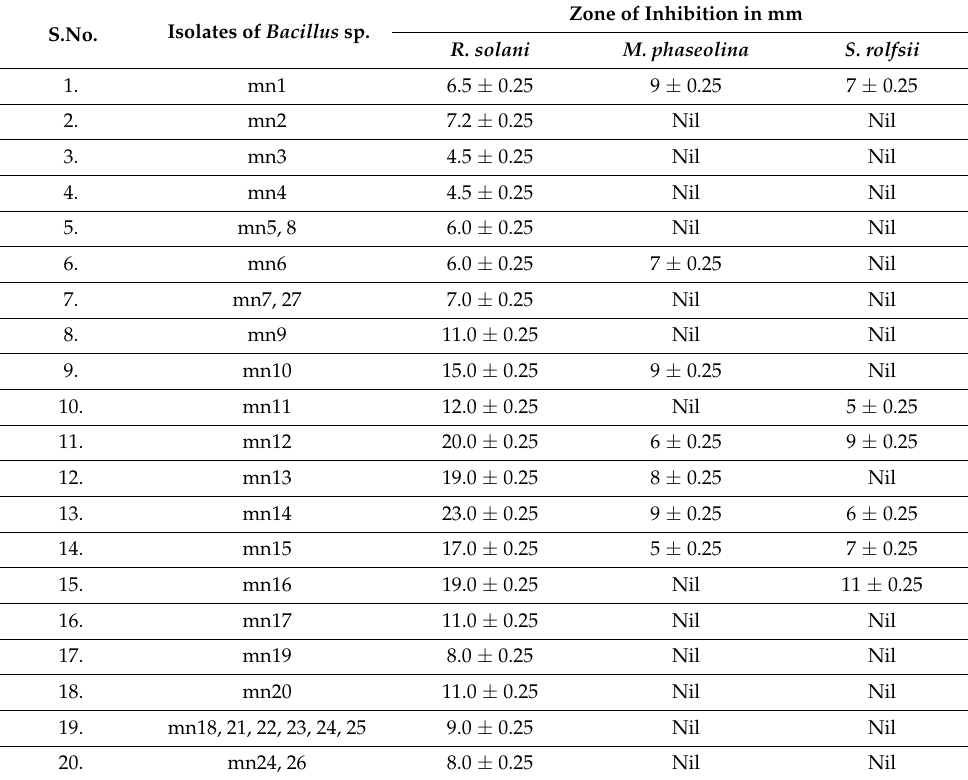
Table 4. Antagonistic activity of Bacillus species toward three fungal pathogens.